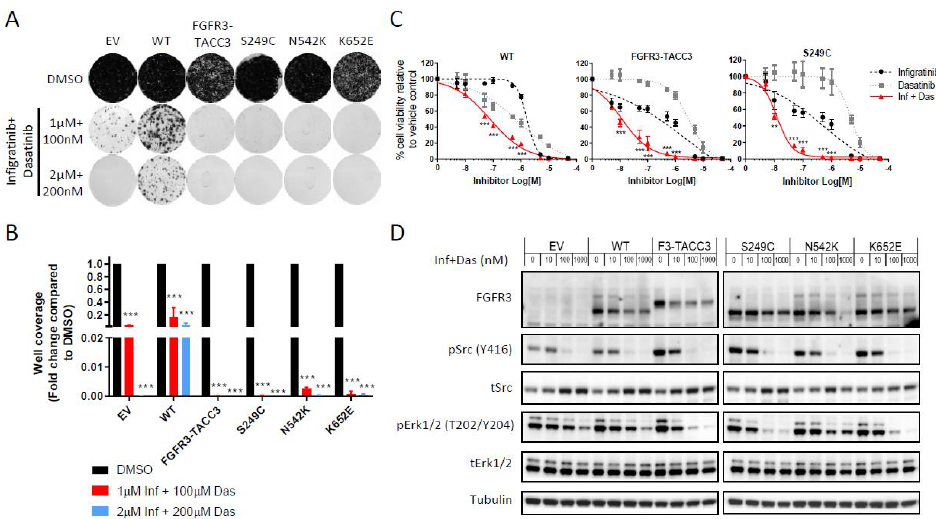
Figure 3. Combination of dasatinib and infigratinib overcomes intrinsic resistance. ( A ) Representative images of long term colony formation assay in the NIH-3T3 cell line panel upon treatment with a combination of dasatinib and infigratinib or DMSO control at the indicated doses for 2 weeks. ( B ) Bar plots showing the quantification of well coverage of the colony formation assay in panel A. Data for each cell line are normalised to DMSO control treatment (n = 3). Statistical analysis of drug treatment versus DMSO was performed by two-way ANOVA with Dunnett’s post-hoc multiple comparison adjusted p -value (*** p < 0.001). ( C ) Dose-response curves of the WT FGFR3, FGFR3-TACC3 and S249C cell lines upon treatment with infigratinib and dasatinib either as single agents or in combination for 72 h. For the combination arm, cells were treated with infigratinib and dasatinib in a 1:1 ratio with each drug at half the dose of the single agent. Cell viability is normalised to DMSO control treatment ( n = 3). Statistical analysis of the combination arm versus either single agent at each dose was evaluated using two-way ANOVA with Dunnett’s post-hoc multiple comparison adjusted p -value at each drug dose (** p < 0.01, *** p < 0.001). ( D ) Immunoblot of Erk1 / 2 and Src phosphorylation levels in NIH-3T3 cells treated with a combination of infigratinib and dasatinib in a 1:1 ratio for 6 h, with the indicated concentration representing to total drug concentration used. Data presented for ( B ) and ( C ) represent mean ± SD. EV – empty vector control, WT – wildtype FGFR3, F3-TACC3 – FGFR3-TACC3, Inf – infigratinib, Das –